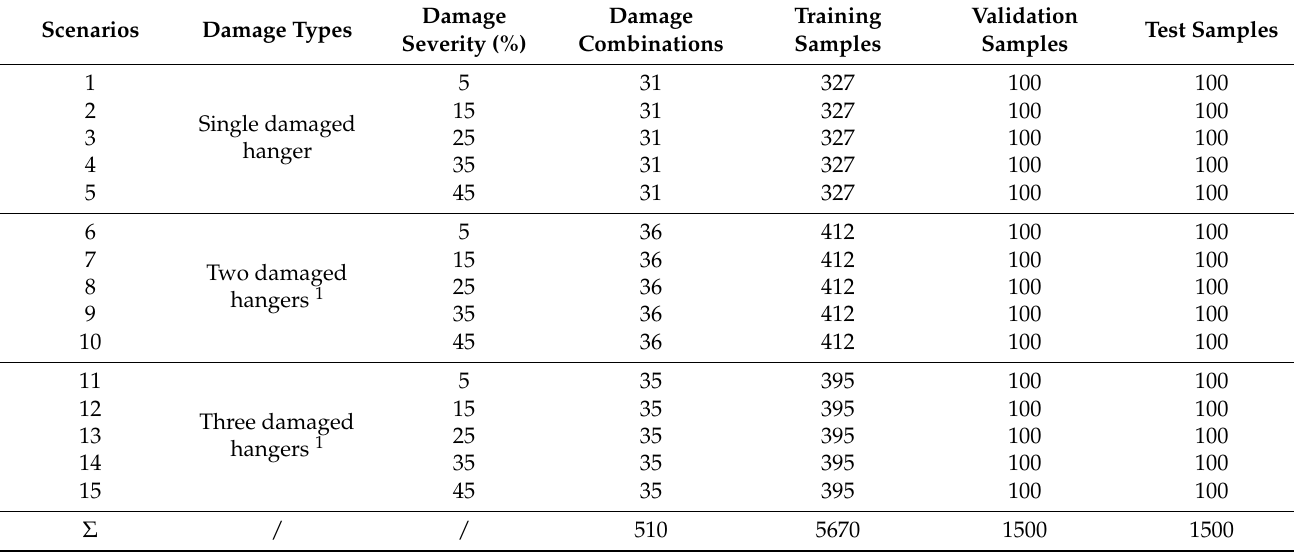
Table 1. Details of damage scenarios and division of samples.